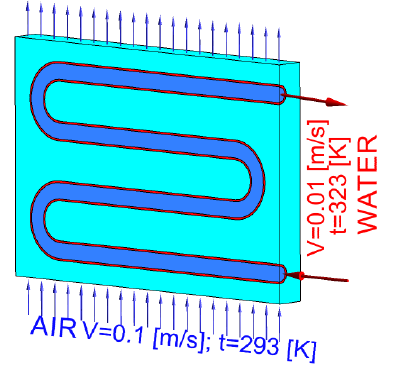
Fig. 5. Boundary conditions